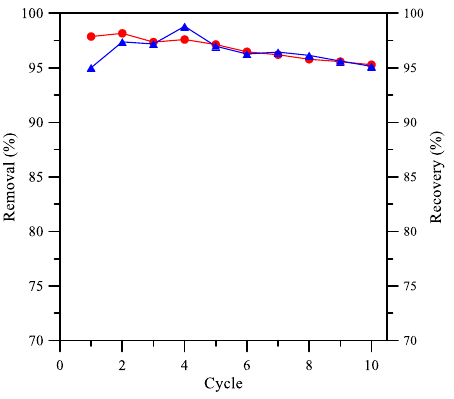
0 Figure 8. Removal and recovery rates in consecutive cycle: (●) removal rate, ( ▲ ) recovery rate. Figure 8. Removal and recovery rates in consecutive cycle: ( ● ) removal rate, ( ▲ ) recovery rate. Figure 8. Removal and recovery rates in consecutive cycle: ( Figure 8. Removal and recovery rates in consecutive cycle: ( ● ) removal rate, ( ▲ ) recovery rate. ) recovery rate. Feeding Feeding phase: [Cr(VI)] = 53 mg/L at pH 4; stripping phase: pH 12; stirring rate: 450 rpm. phase: [Cr(VI)] = 53 mg/L at pH 4; stripping phase: pH 12; stirring rate: 450 Feeding phase: [Cr(VI)] = 53 mg/L at pH 4; stripping phase: pH 12; stirring rate: 450 rpm. Feeding phase: [Cr(VI)] = 53 mg/L at pH 4; stripping phase: pH 12; stirring rate: 450 rpm.